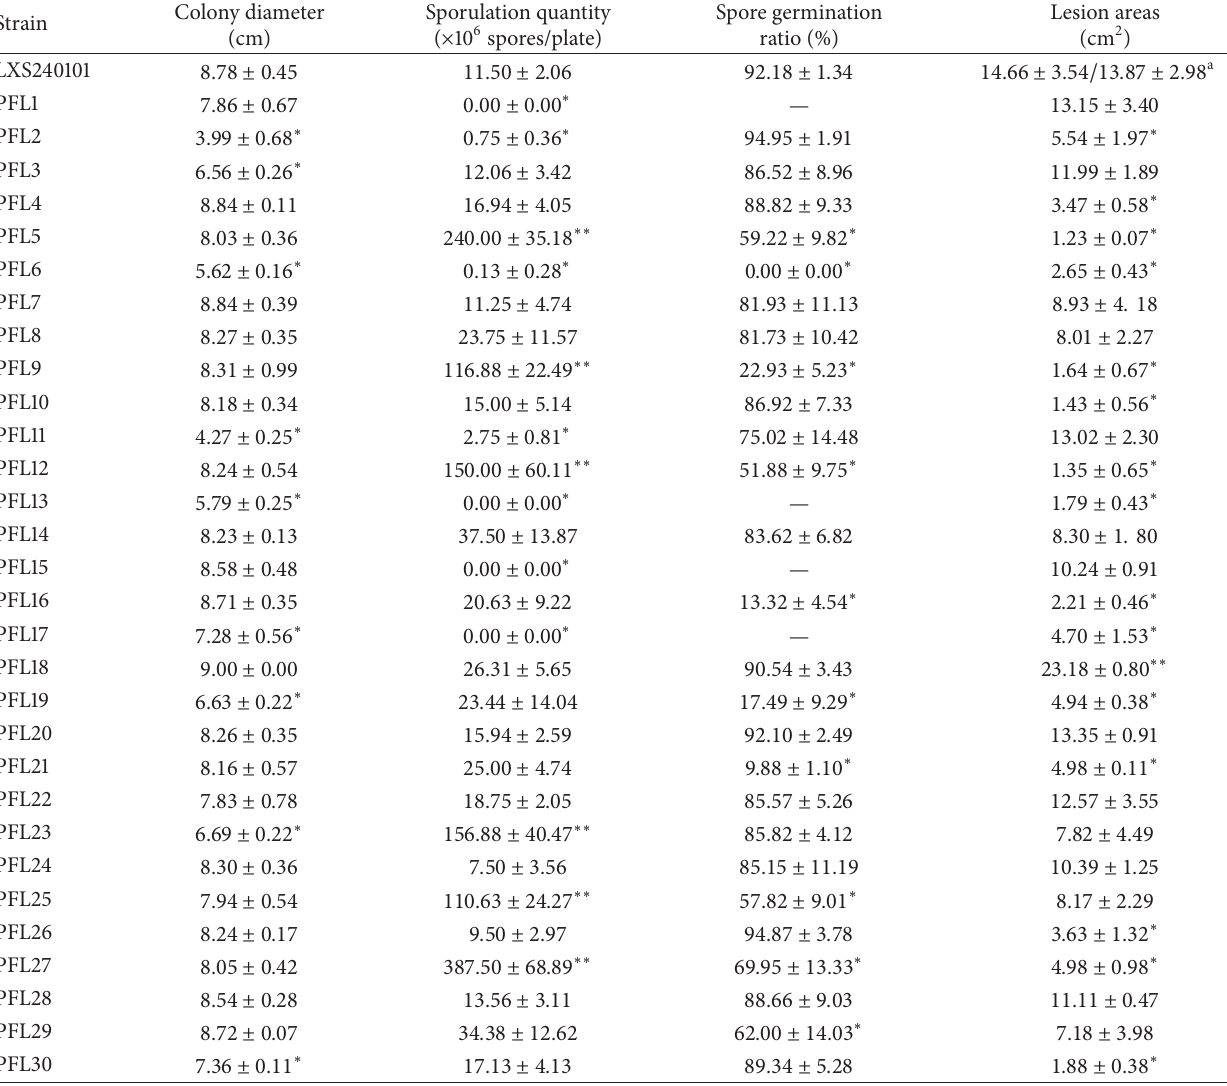
Table 1: Comparison of some important biological properties and pathogenicity between transformants and wild-type strain LXS240101. Colony Strain